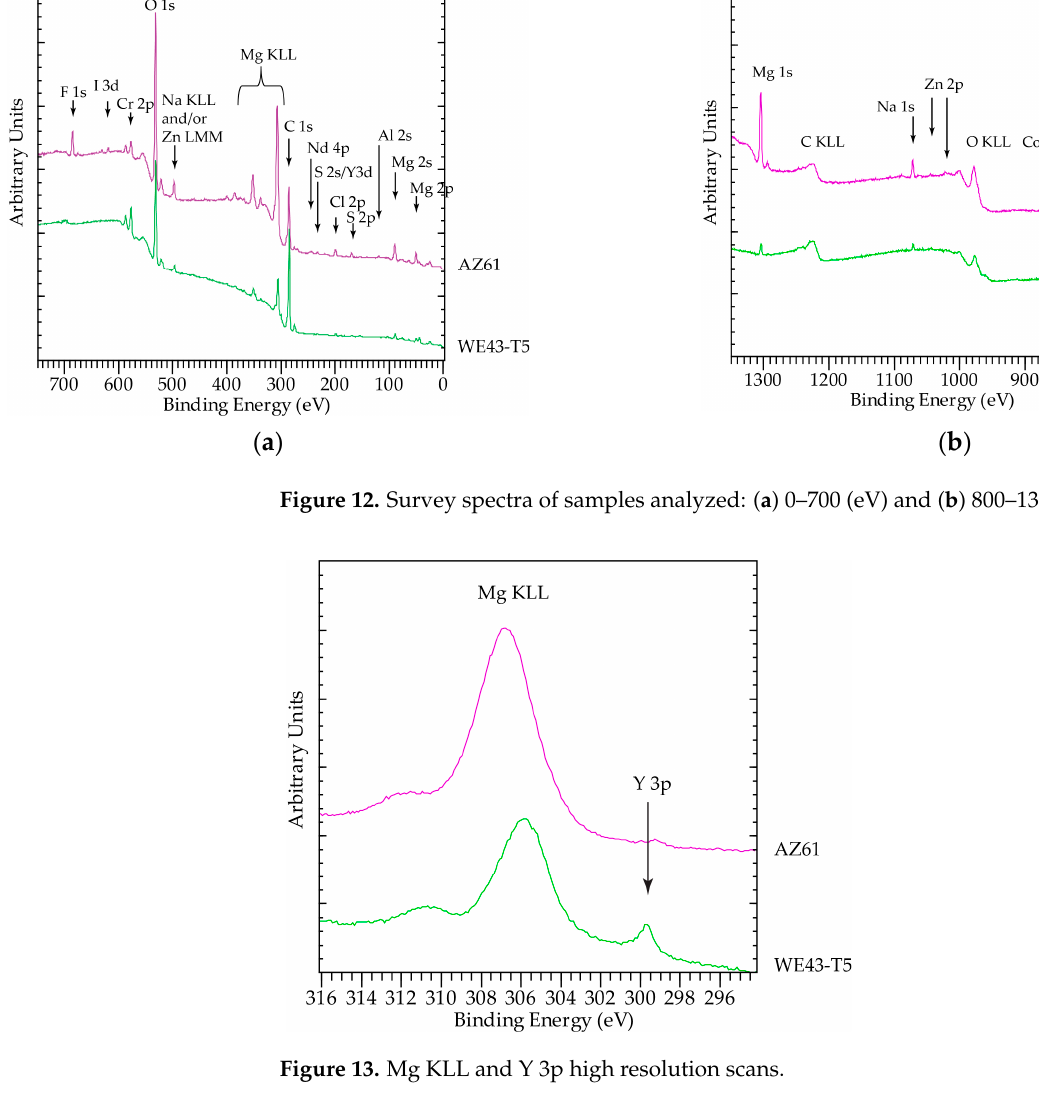
Figure 15. High resolution O1s scans. The peak position corresponds to OH - and/or adsorbed spe- cies. Table 5. Mg 2p-KLL and Mg 1s-KLL final state Auger parameters in corroded surfaces. AZ61